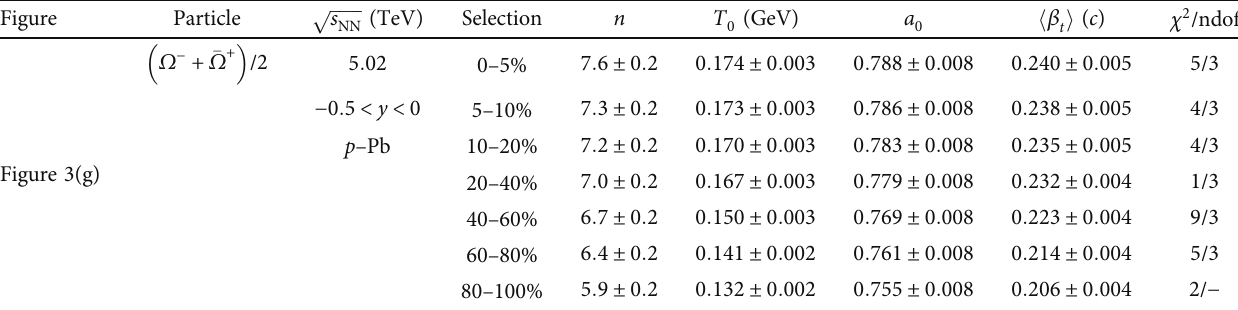
(cid:1) K ∗ 0 Þ /2 the p T spectra of (a) K + + K − , (b) ð K ∗ 0 + , (c) K 0 S , (d) the panels are all quoted from the ALICE Collaboration when the midrapidity is 0 < y < 0 : 5 (a, c, e) and − 0 : 5 < y < 0 (b, d, f, g) [44, 45]. Di ff erent symbols indicate the di ff erent solid curves. The coe ffi cients in parentheses are magni fi ca-